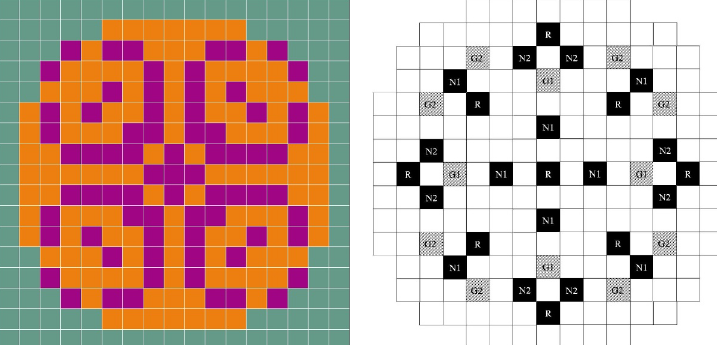
Figure 1: On the left: map of the assemblies in the core (UO in orange, UGd in purple). On 2 the right: map of the control